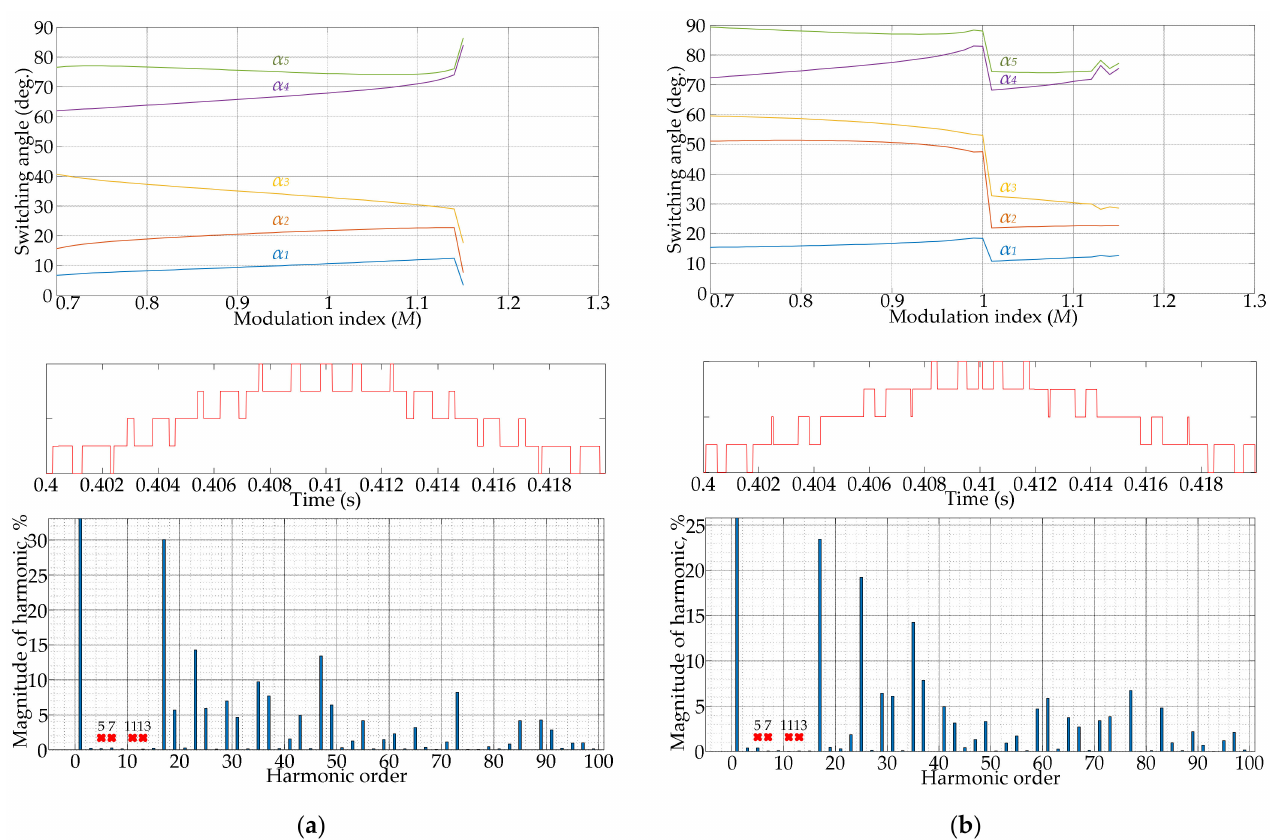
Figure 11. Results of solution trajectories, PPWM waveforms and FFT spectra for six-pulse connection scheme based on PSO algorithm: ( a ) SHE problem with five switching angles—Case 2; ( b ) SHE problem with seven switching angles—Case 3.